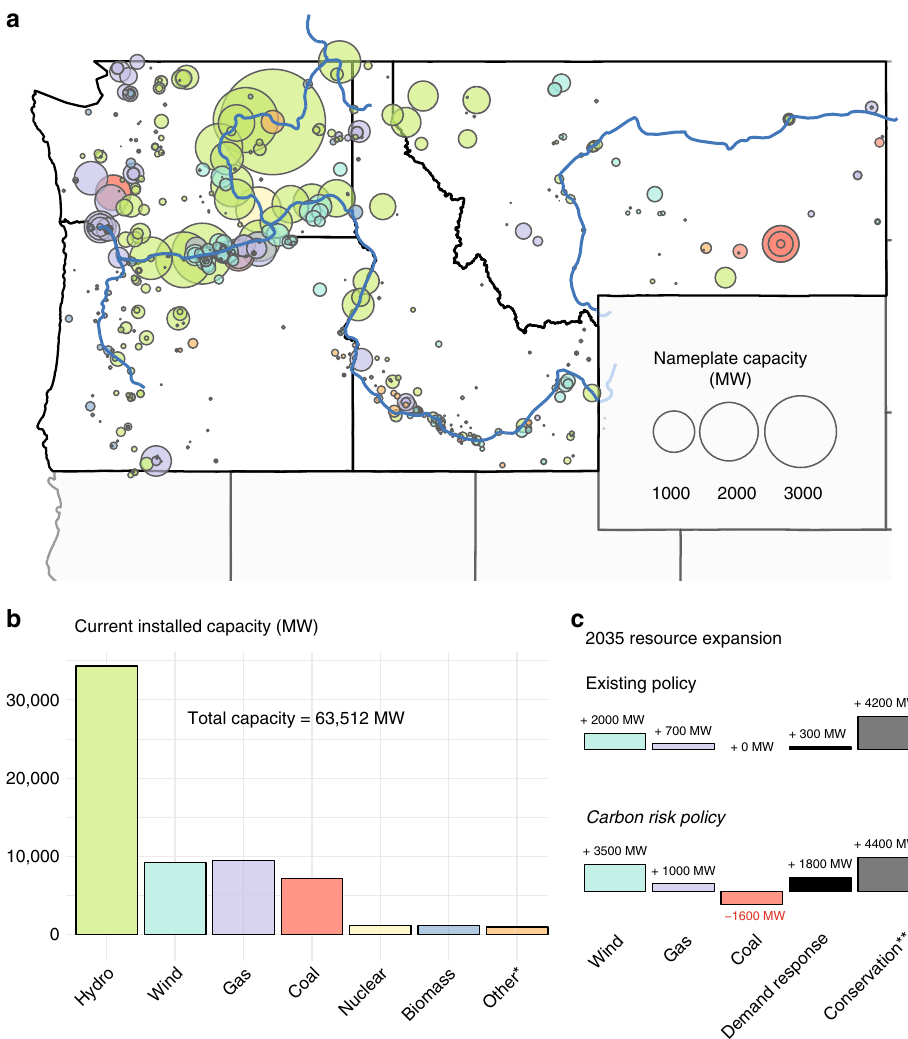
Fig. 1 Power plants by resource type in the U.S. Paci fi c Northwest. *Other comprises petroleum, solar, geothermal, and energy storage (pumped storage hydropower and battery). **Conservation is measured in MWa (i.e., annual average generation), not MW (nameplate